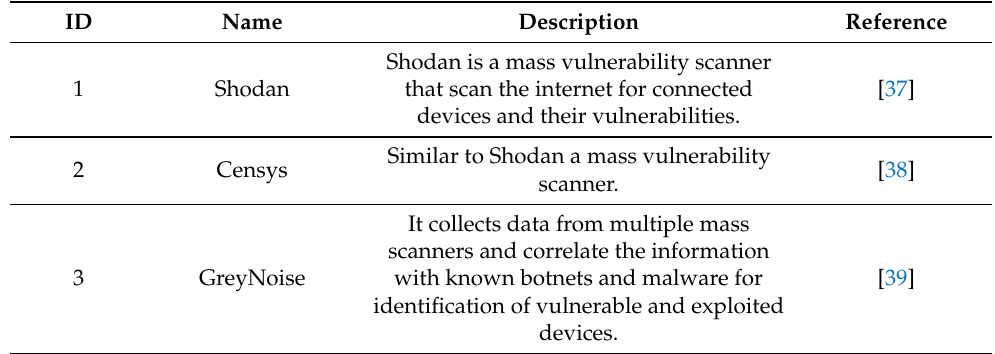
Table 5. Tools used for OSINT on vulnerability search engines.